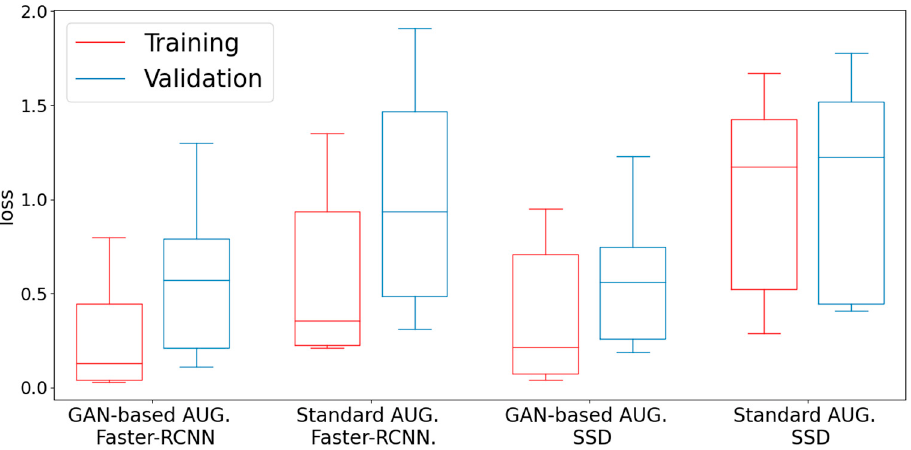
Figure 16. Boxplot visualizing the differences in the minimum training and validation losses between the proposed augmentation pipeline and the standard augmentation method.